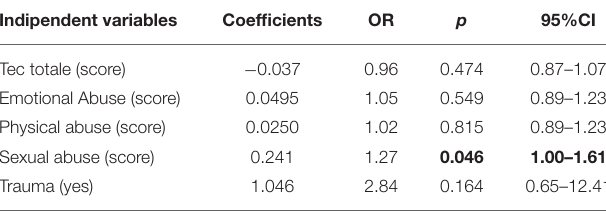
TABLE 3 | Factors related to personality disorder (multivariable